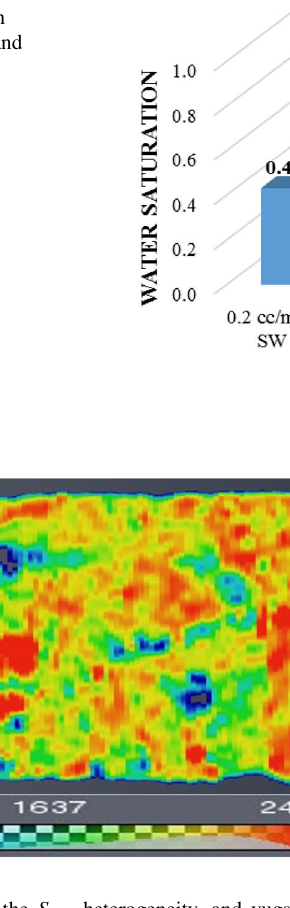
Fig. 12 CT image showing the S OR , heterogeneity, and vugs in the core plug used for Exp. 2. High CT number indicating high density